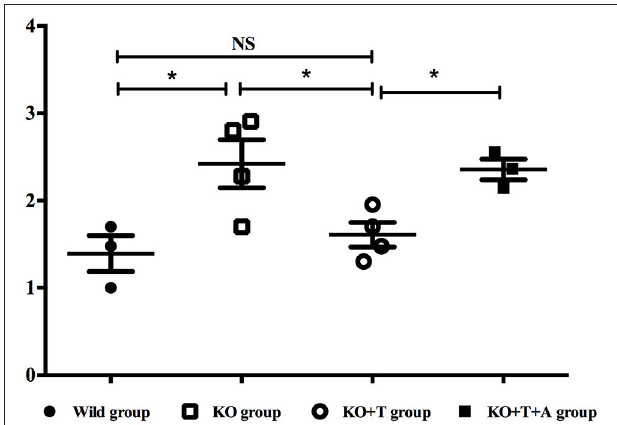
FIGURE 5 | Effect of IL17- γδ T cells on bacterial clearance. BALF was obtained on day 7 post infection following cannulation of the trachea and three infusions of 1 ml cold PBS containing 0.5 mM EDTA. A portion of the BALF (100 µ l), which corresponded to 10 CFU ml − 1 , was plated on LB agar and incubated overnight at 37 ◦ C to determine the bacterial load. * p < 0.05. These results represent three independent experiments.